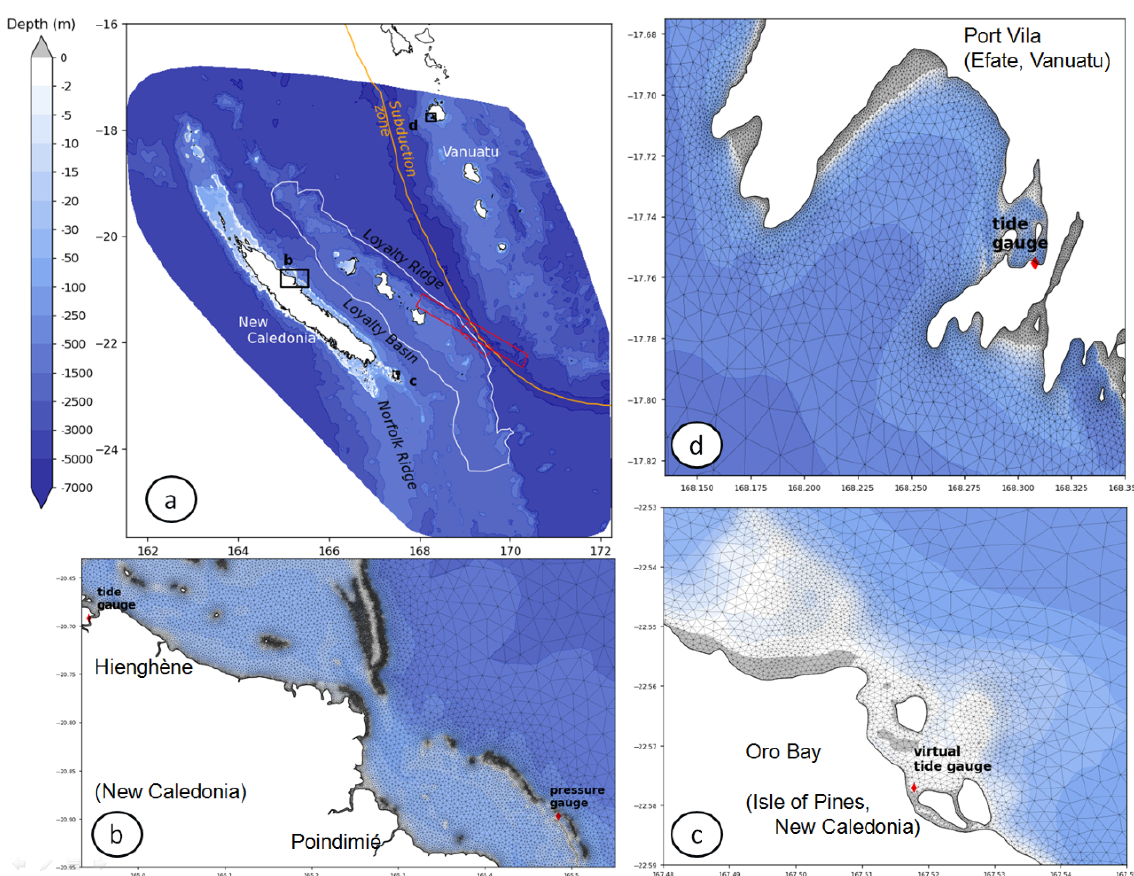
Figure 5. Triangular irregular network (TIN) DEM including New Caledonia and southern Vanuatu islands. The three insets show mesh details and the location of some gauges (see black boxes b–d for exact locations). In (a) , extents of both the non-uniform and uniform slip models considered in this study are displayed with solid and dashed red lines respectively. The white contour indicates the area of the Loyalty Ridge where the ocean bottom is modified to further investigate the impact of this ridge on the wave propagation (see Discussion and Fig.